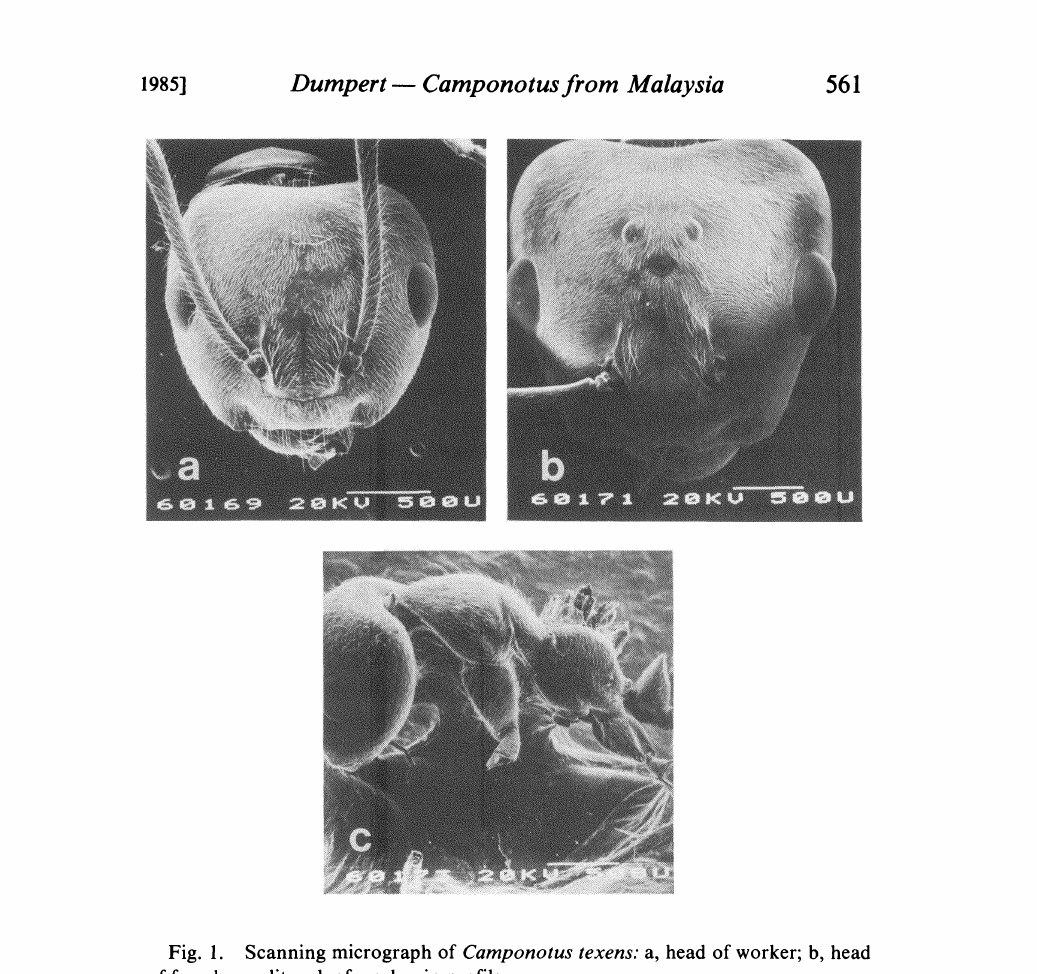
Fig. 1. Scanning micrograph of Camponotus texens: a, head of worker; b, head of female; c, alitrunk of worker in profile. of gaster dark brown; sternites lighter brown; front of head, distal antennal flagellum and legs yellow brown. Wings yellowish, veins yellow brown. Head, alitrunk and gaster covered with fine, light yellow, decum- bent pubescence. Longer erect hairs distributed over the whole body. Eyes distinctly larger than those of workers and situated behind the midlength of the sides of the head. OD 0.69 mm, or about 0.30 HW. Petiole with a broad base, tapering toward the apex into a narrow ridge, seen from the